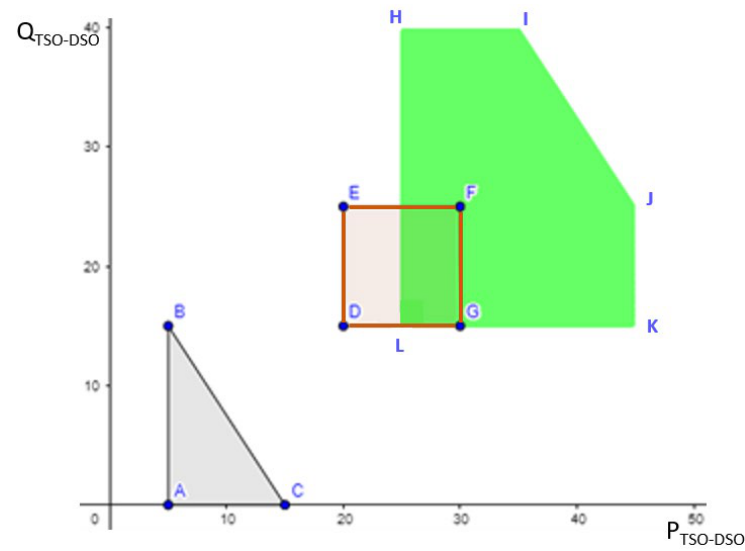
Figure 3. A simple example of the calculation of the M-sum.